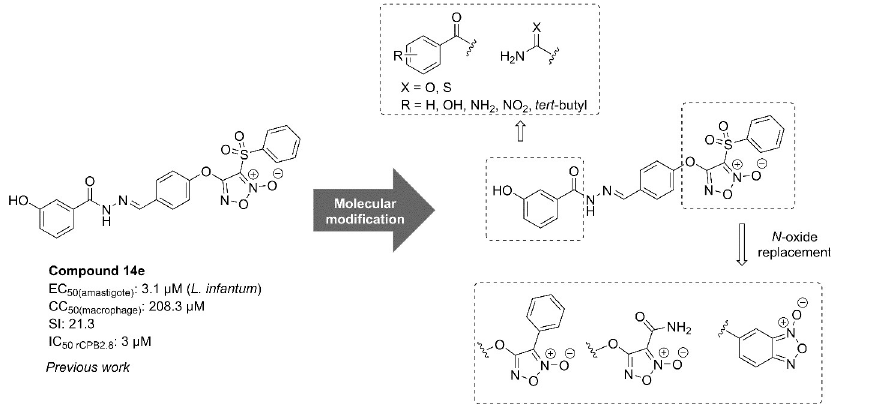
Fig 1. Drug design of the new